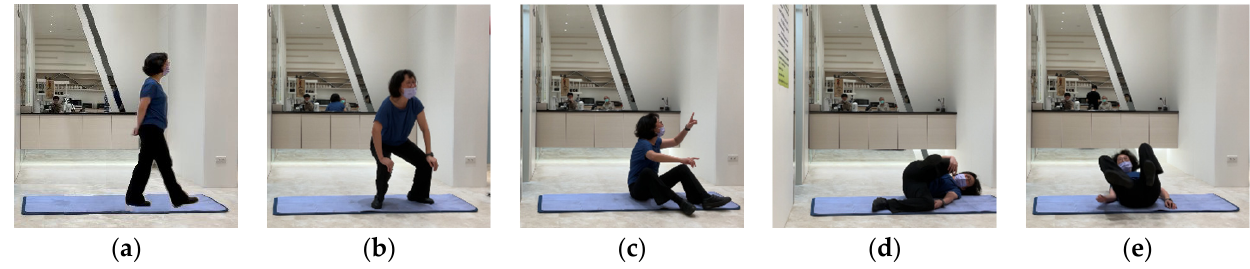
Figure 6. Five kinds of human pose images in a fall event detected: ( a ) walking; ( b ) squatting; ( c )